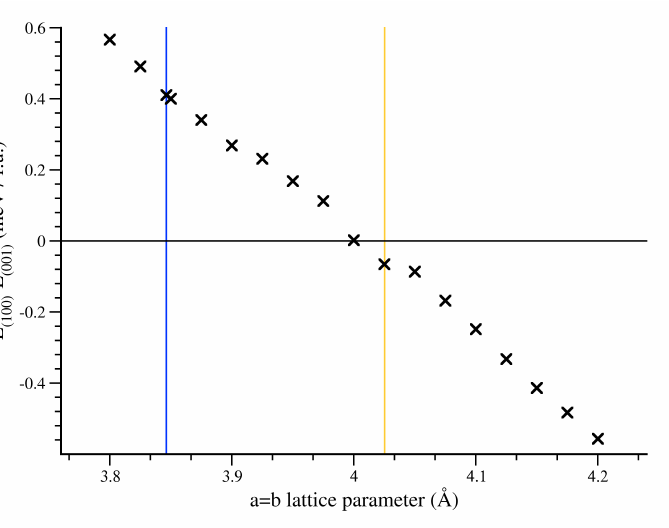
Figure 9. Change of energy difference between (cid:126) c - and (cid:126) a -aligned spin structures with strain. Note that the MAE is the absolute value of this number, and the sign change indicates a strain-induced alteration of the easy and hard magnetic axes. The blue line represents the LDA lattice parameter, and the yellow line indicates the LDA+U lattice